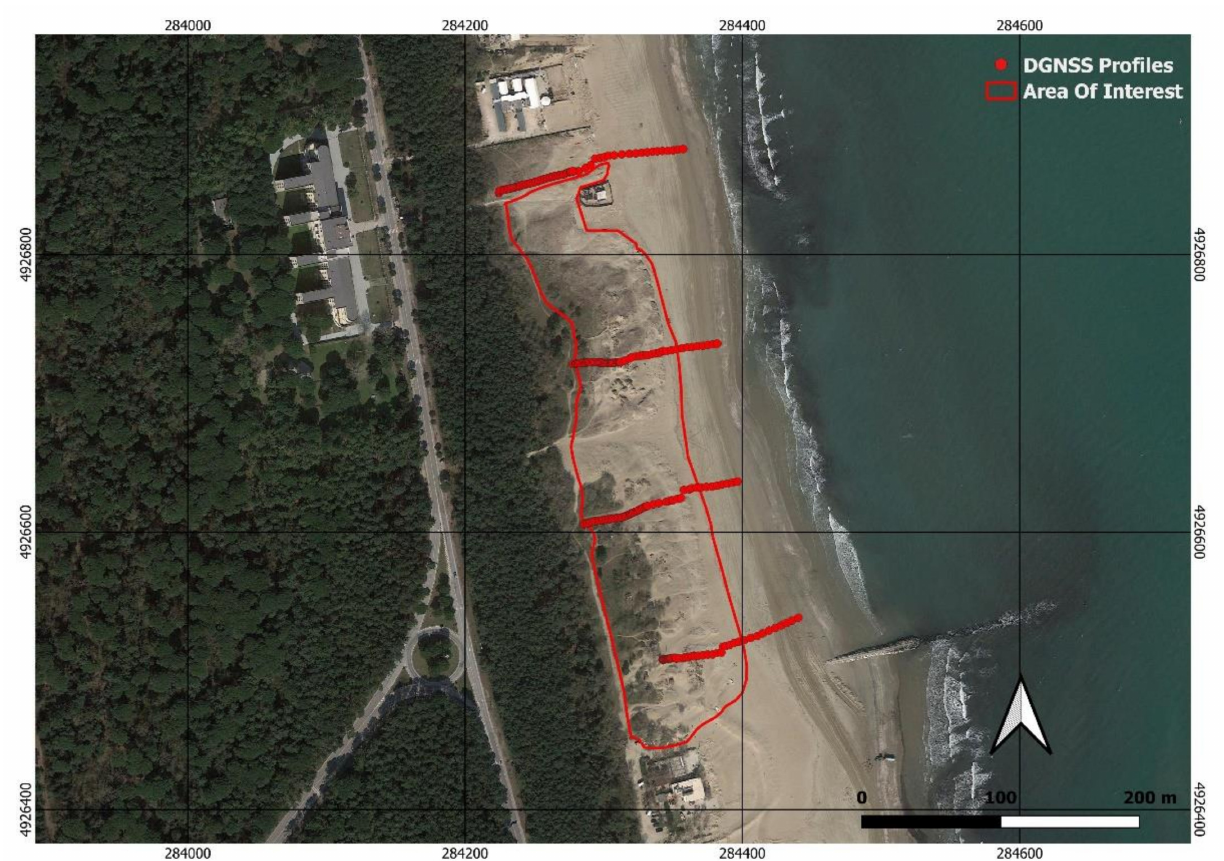
Figure 1. Satellite orthogonal image, from March 2015, of the Punta Marina study site pre-restoration works. The red line includes the selected area of interest (AOI) for this study, corresponding to the dune residual (31,568 m 2 ). The four red cross-shore lines are the DGNSS profiles used to validate the entire Digital Surface Model (DSM).